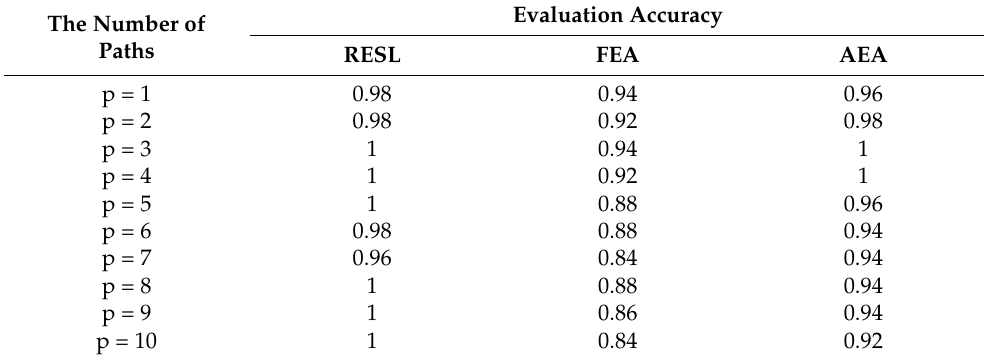
Table 1. Evaluation